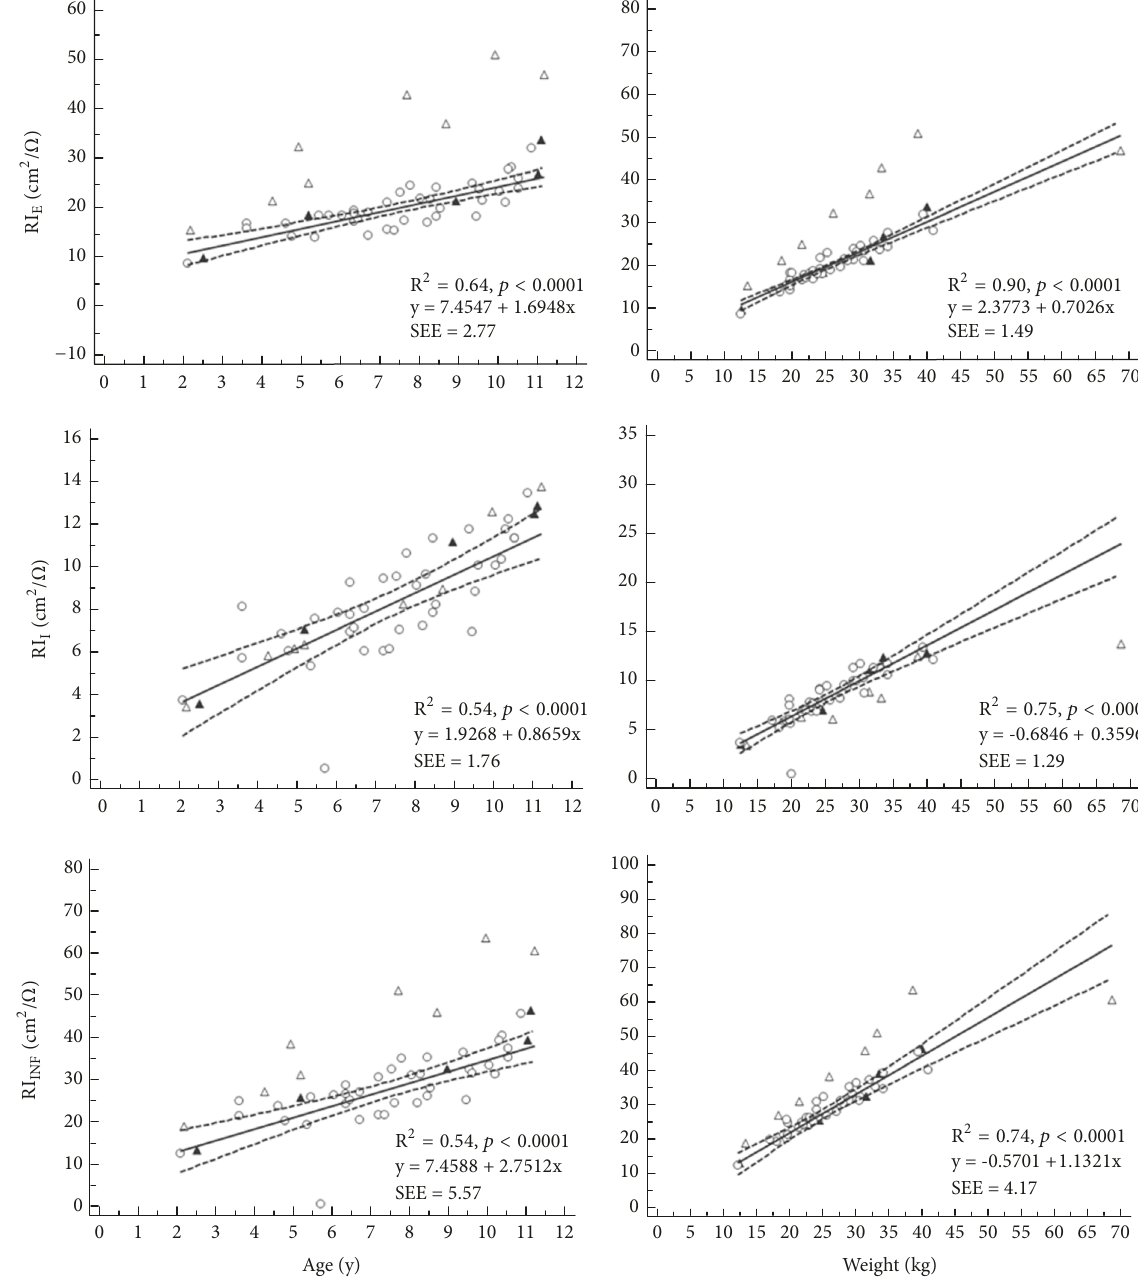
Figure 2: Relationship between resistance indices and age (left panel) and weight (right panel); (cid:2) : ANS, 󳵳 : NSR, and I : HC, see Table 1 for group descriptions; dashed lines are 95% confidence intervals for regression lines based on the HC